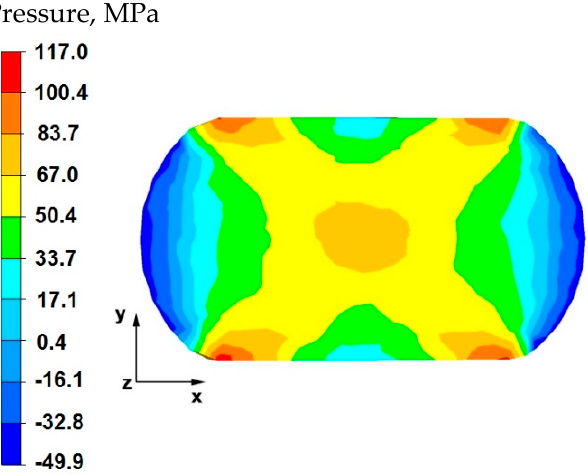
Figure 5. Distribution of hydrostatic pressure values on the surface of the cross-section of the sample with modeled discontinuity—after deformation with 35% reduction.